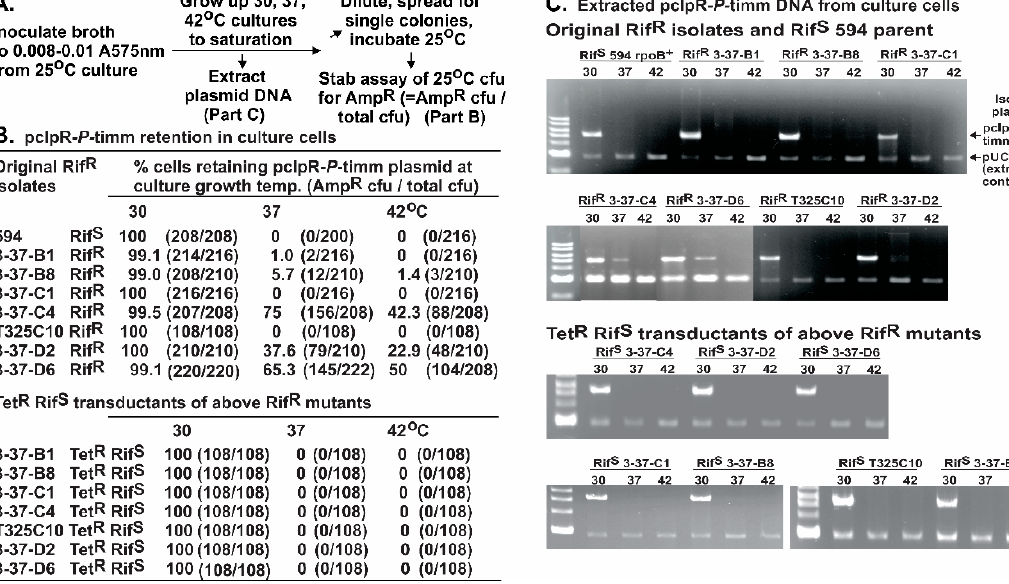
Figure 5. pcIpR ‐ P ‐ timm retention in P S and P R Rif R isolates and for Rif S transductants. ( A ) Outline of